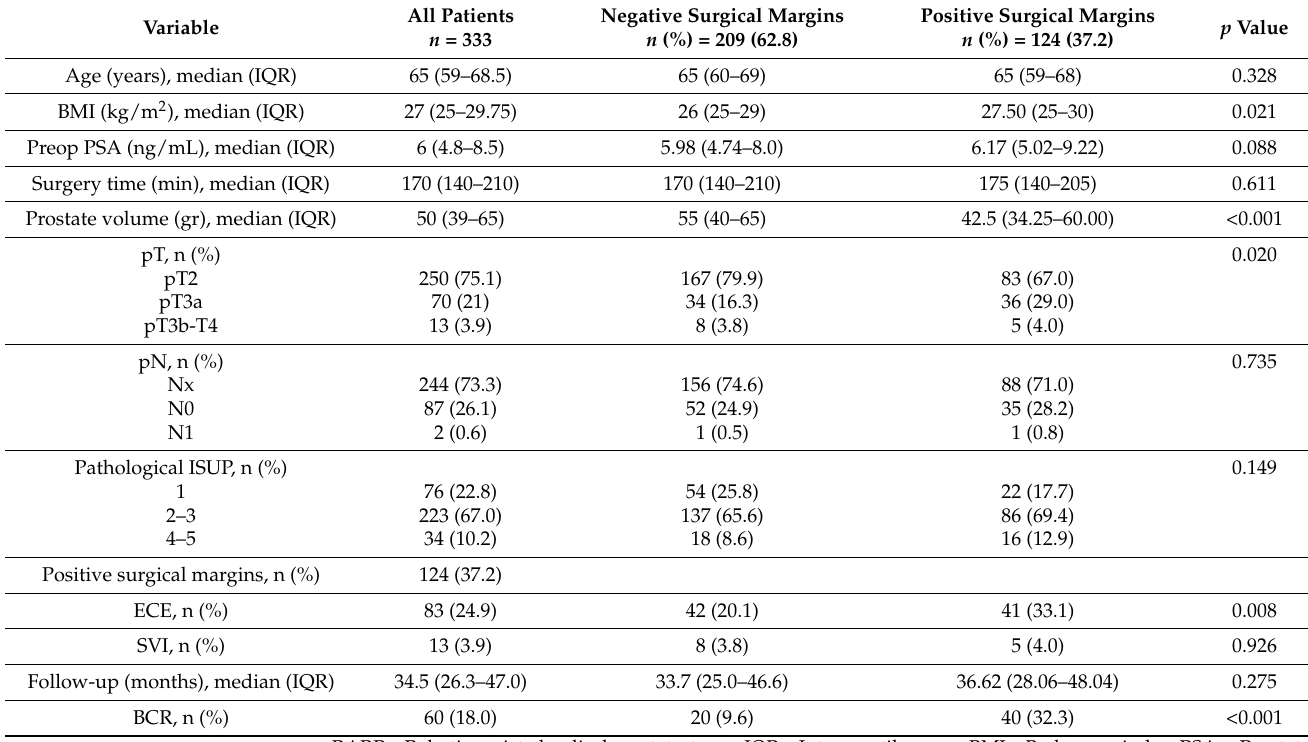
Table 1. Characteristics of patients that underwent RARP between 2015–2020 were stratified by margin status.